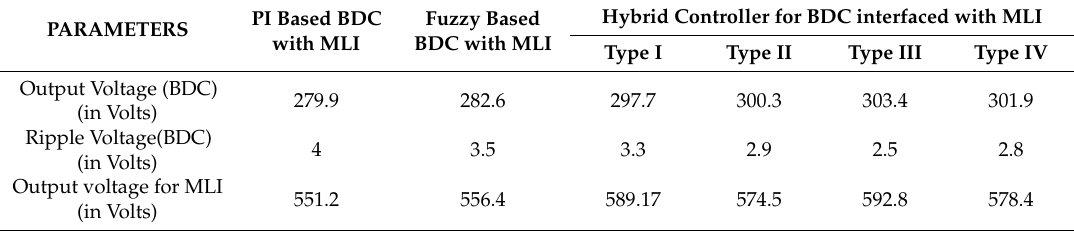
Table 8. Comparison of proposed controller circuits for BDC interfaced with MLI.